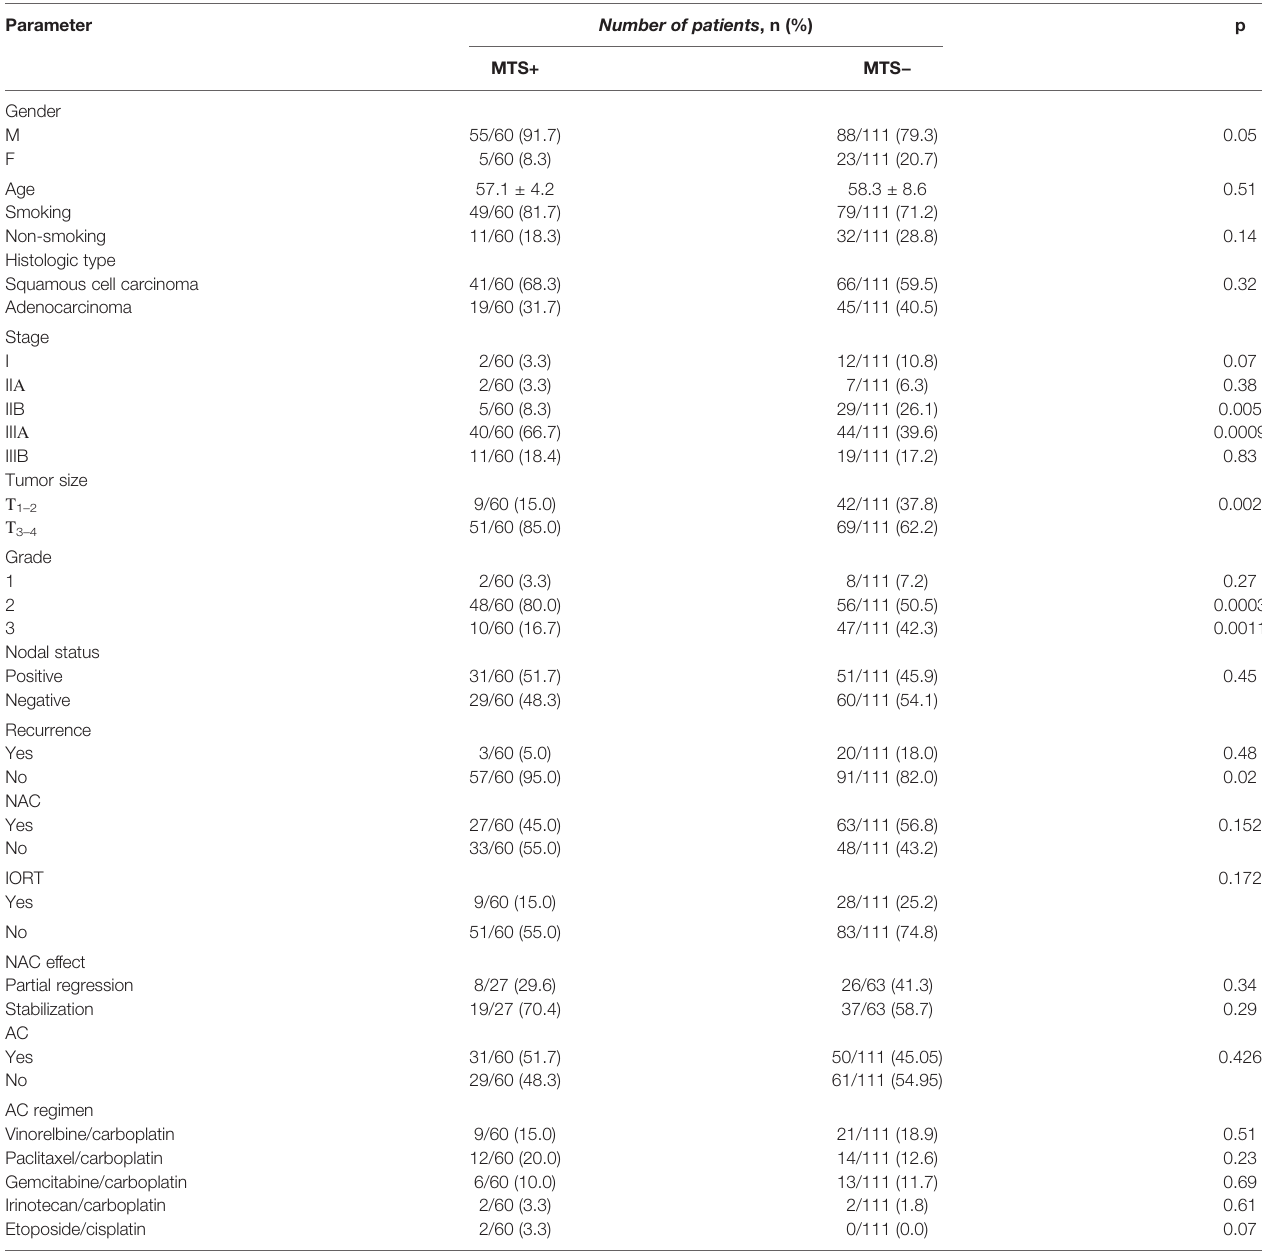
TABLE 1 | Clinicopathologic features of NSCLC patients with or without distant